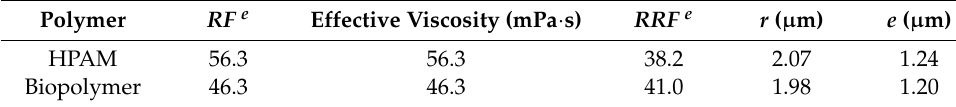
Table 6. Summary of core flood